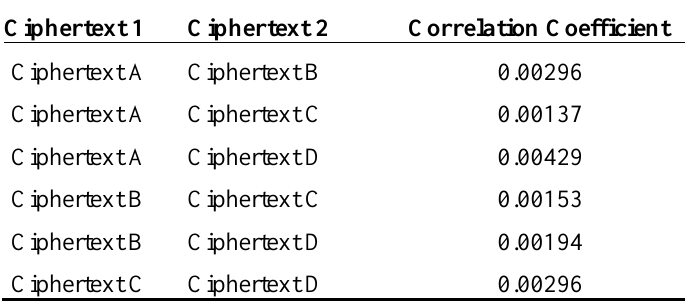
Table 7. The correlation coefficients of the ciphertexts.